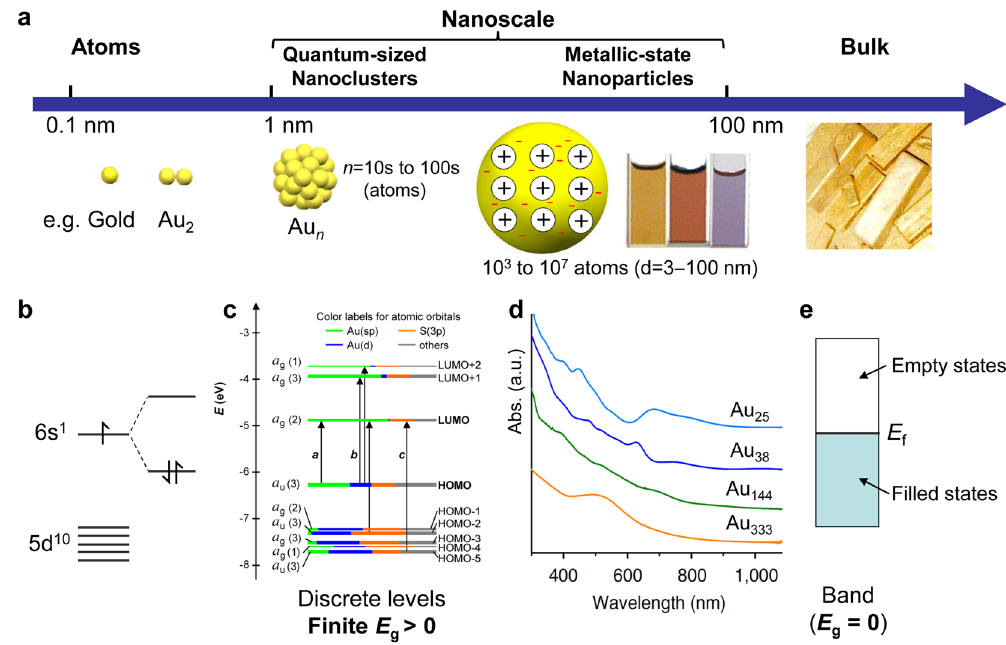
Fig. 1 The evolution from atomic building blocks, to nanoscale, to bulk metals. a The nanoscale (1 – 100 nm) exhibits two distinct size regimes (quantum- sized: 1 – 3 nm (tens to hundreds of atoms), and regular metallic-state nanoparticles: 3 – 100 nm). b Atomic and diatomic electronic states. c Molecule-like electronic structure in quantum-sized nanoclusters (where, HOMO = highest occupied molecular orbital, LUMO = lowest unoccupied molecular orbital, E = HOMO-LUMO gap). d Evolution from discrete electronic excitation to collective electron excitation (plasmon) in optical absorption spectra with g increasing size of nanoclusters. e Continuous band electronic structure of metallic-state nanoparticles and bulk metals (where, E f = Fermi